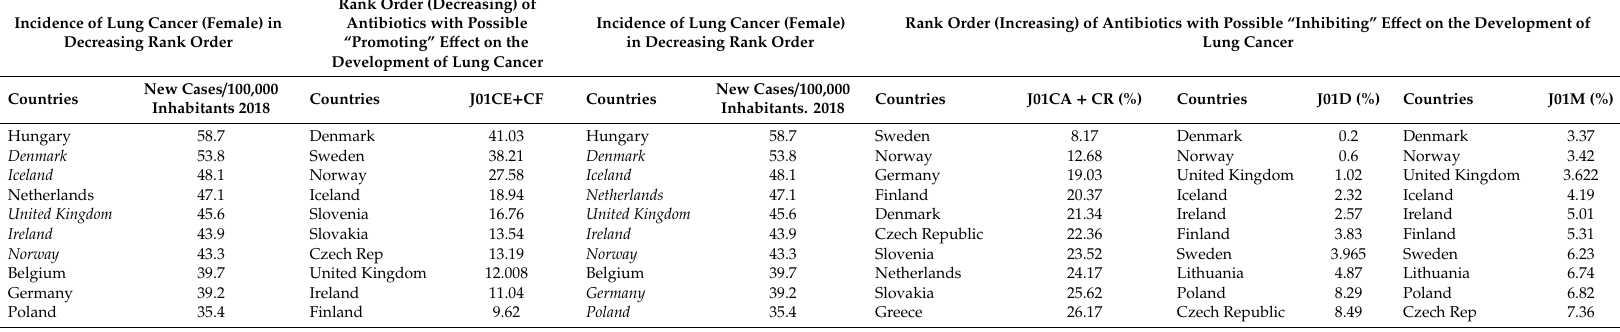
Table 4. Rank order (decreasing) of the incidence of female lung cancer (10 countries) compared to the rank order (decreasing) of antibiotics with suspected “promoter” e ff ect and the increasing (reverse) rank order of suspected “inhibitor” e ff ect of antibiotics. Out of the first ten countries with the highest incidence rate of female lung cancer, five countries can be found among the highest consumption figures of “promoter” antibiotics (bold, italics). Eight countries with the lowest consumption figures of “inhibitor” antibiotics are among the firs high incidence rate of female lung cancer (bold, italics). Incidence of Lung Cancer (Female) in Decreasing Rank Order